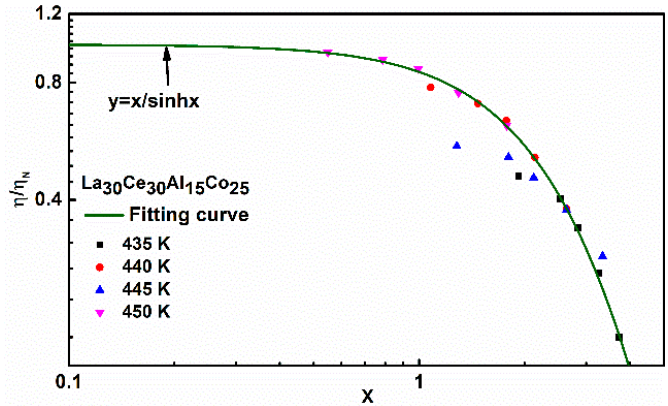
Figure 10. Master curve between normalized viscosity η/η N and X at different temperatures, where X= σV/(2√3KT) . The solid line is fitted by Equation (7).